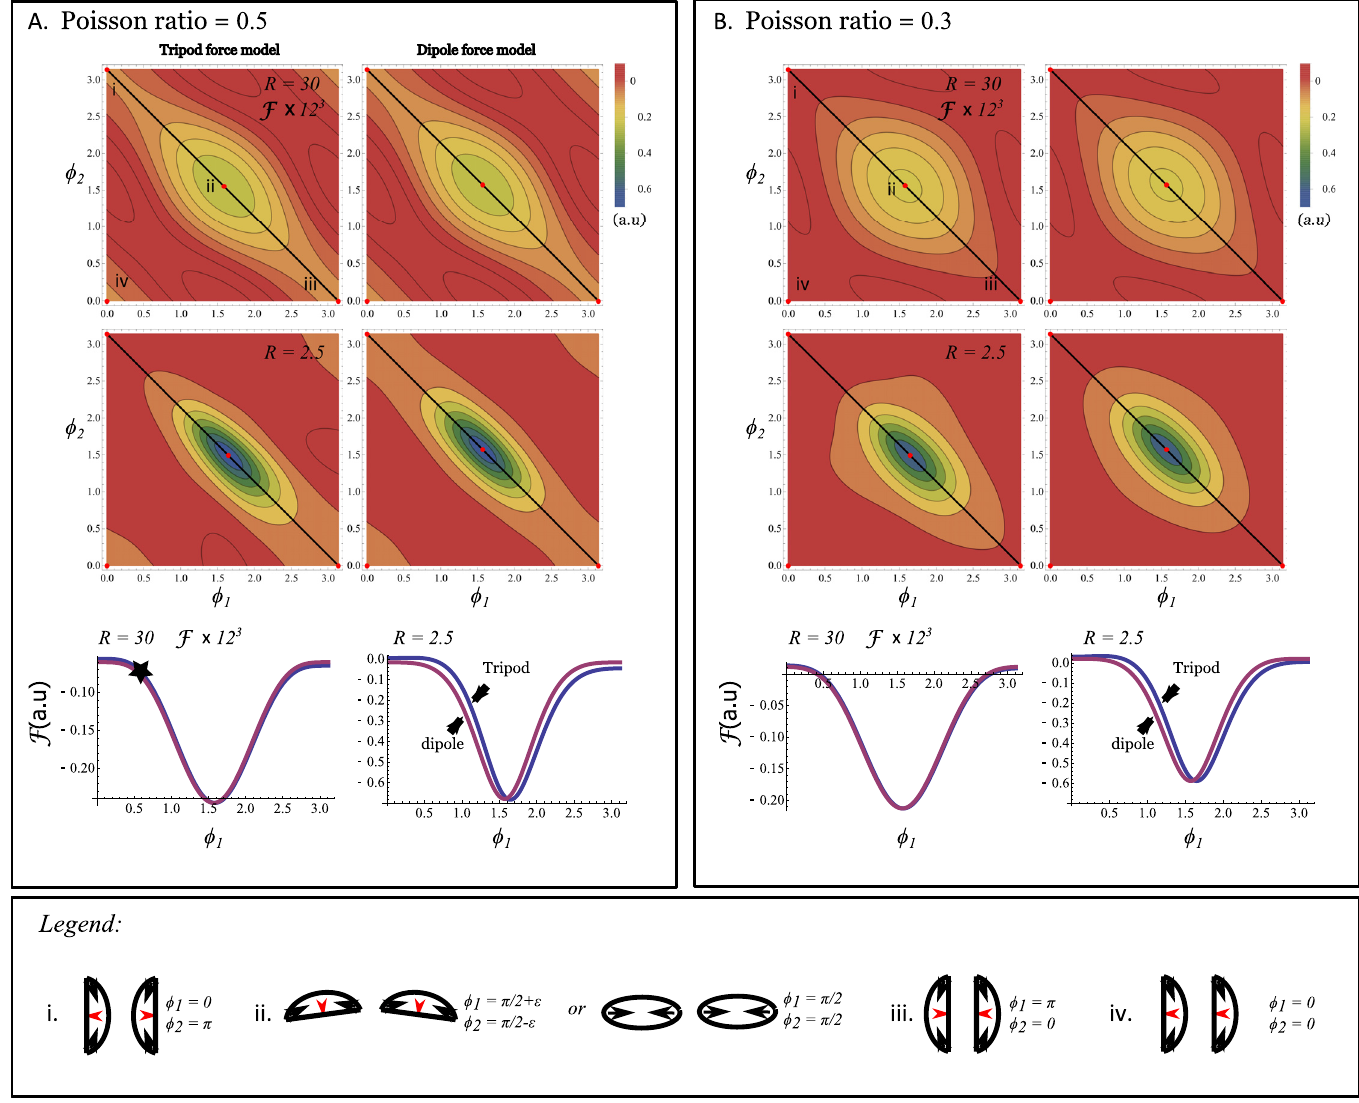
Fig 5. A. and B. show the interaction energy landscape, F given by Eq (1) in arbitrary units, between two tripods (left) and dipoles (right), both lying on the x -axis and separated by a distance R = 30 d (top) and R = 2.5 d (bottom). Note that the large separation interaction energy has been multiplied by 12 3 to put it on the same scale as the one for short cell separation. Local extrema in the cell’s orientation space ( ϕ 1 , ϕ 2 ) are indicated by labels i , ii , iii and iv . The configurations associated with the four extrema are illustrated in the legend. A one-dimensional slice of the interaction energy is shown in the bottom plots for ϕ 2 = π − ϕ 1 (the diagonal line in the top contour plot that includes the first three extrema). The global minimum is the extremum labeled by ii ; when two side-by-side cells point in the same direction for perfect dipoles, or when they are slightly tilted from each other for tripods. Panel A shows the results obtained with a fully incompressible substrate with Poisson ratio σ = 0.5, while the results shown in Panel B are obtained with σ = 0.3. Arbitrary units have been used for simplicity and because the response of the cells due to substrate-mediated interactions is controlled by another parameter ( ξ in Eq (10)). Estimations of the latter parameter goes beyond the scope of the present study. energy landscape. These correspond to the four orientations illustrated in the legend of the fig- ure. Unsurprisingly, at large distances, the tripod and dipole force configurations predict the same preferred orientations between the cells. Also, the differences in energy between all con- figurations are small. When the distance between the two cells is reduced, the tripod and dipole force model have qualitative differences. First, at small distances (see Fig 5A that shows R = 2.5 d ), the symmetry about the ϕ 1 = ϕ 2 axis is clearly lost for tripods but it is preserved for